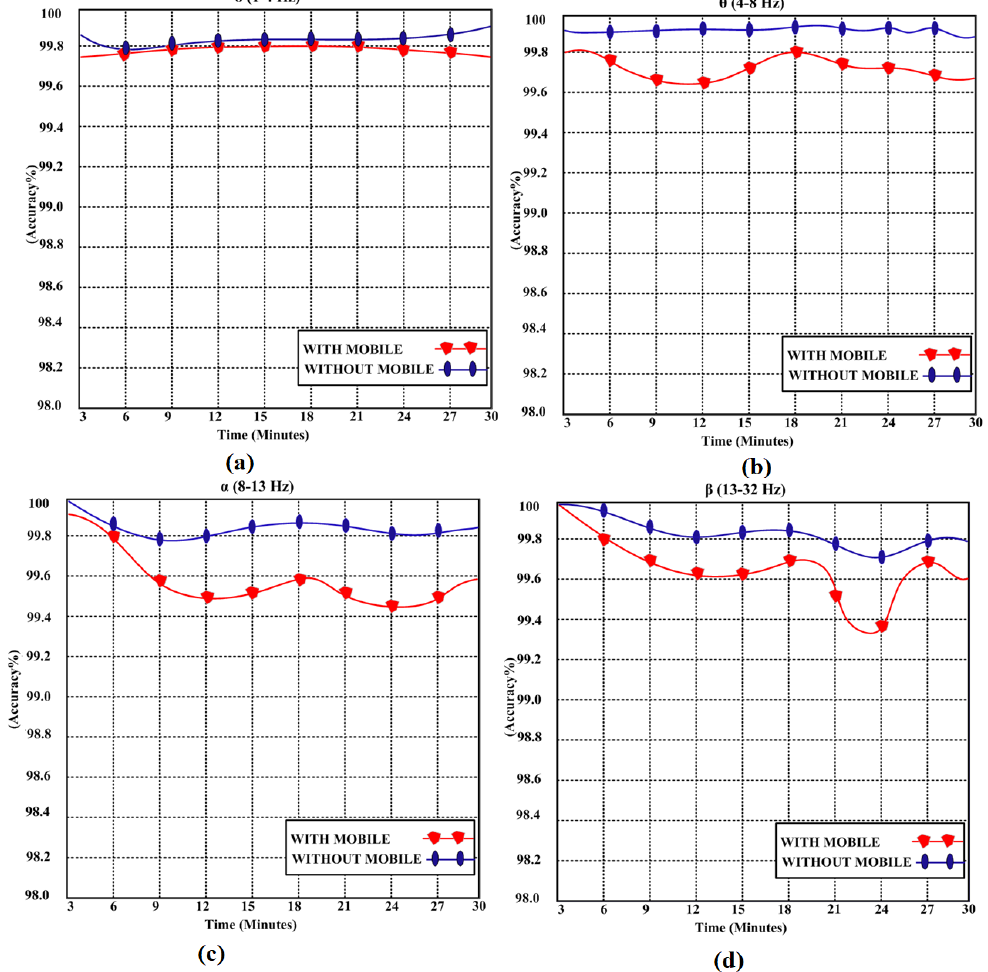
Figure 8. ( a ) The accuracy of the average spectrum exposure with and without GSM using the frequency range of delta δ (1–4 Hz). ( b ) The accuracy of the average spectrum exposure with and without GSM using the frequency range of theta θ (4–8 Hz). ( c ) The accuracy of the average spectrum exposure with and without GSM using the frequency range of alpha α (8–13 Hz). ( d ) The accuracy of the average spectrum exposure with and without GSM using the frequency range of beta β (13–32